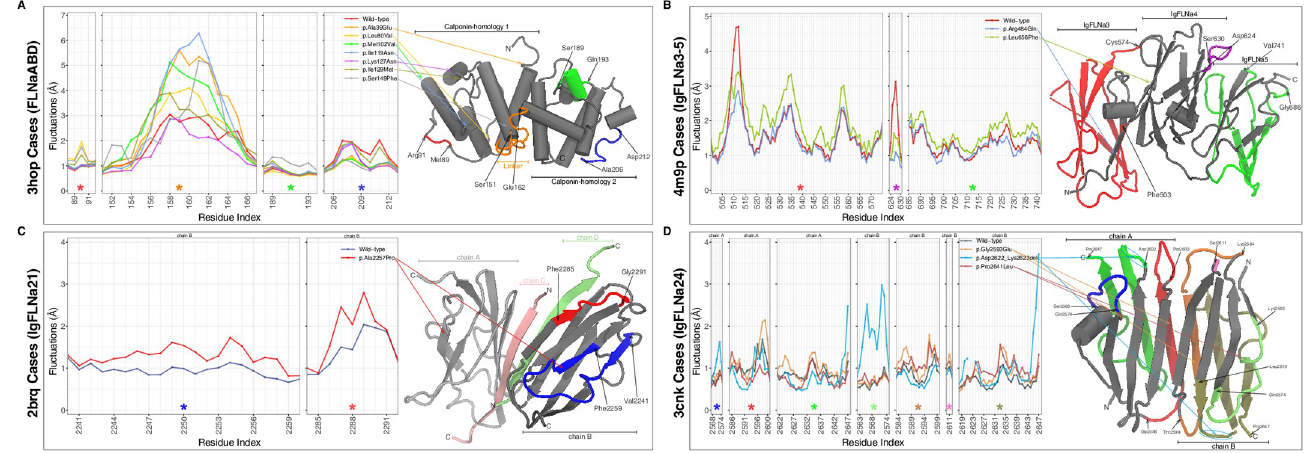
Fig 3. Average C α root-mean-square fluctuations (RMSF) of the amino acids during the simulations. Only the regions whose flexibility is affected by the variants are demonstrated. They are highlighted on the cartoon representation of the structural parts of filamin-A (FLNa): (A) FLNaABD, (B) IgFLNa3-5, (C) IgFLNa21 and (D) IgFLNa24. † Colored stars at the bottom of the panels and the colored regions on the structure representation refer to the same region on FLNa.